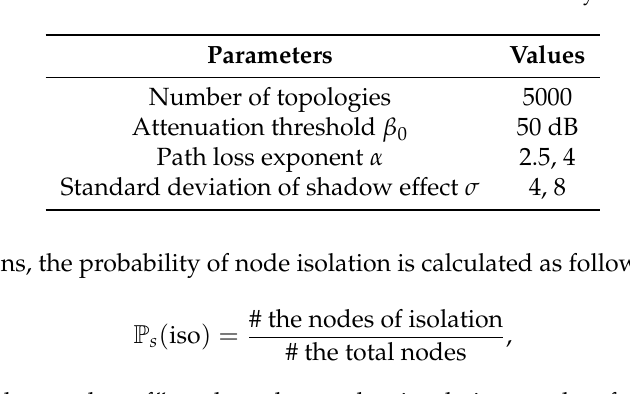
Table 4. Parameters in simulations of local